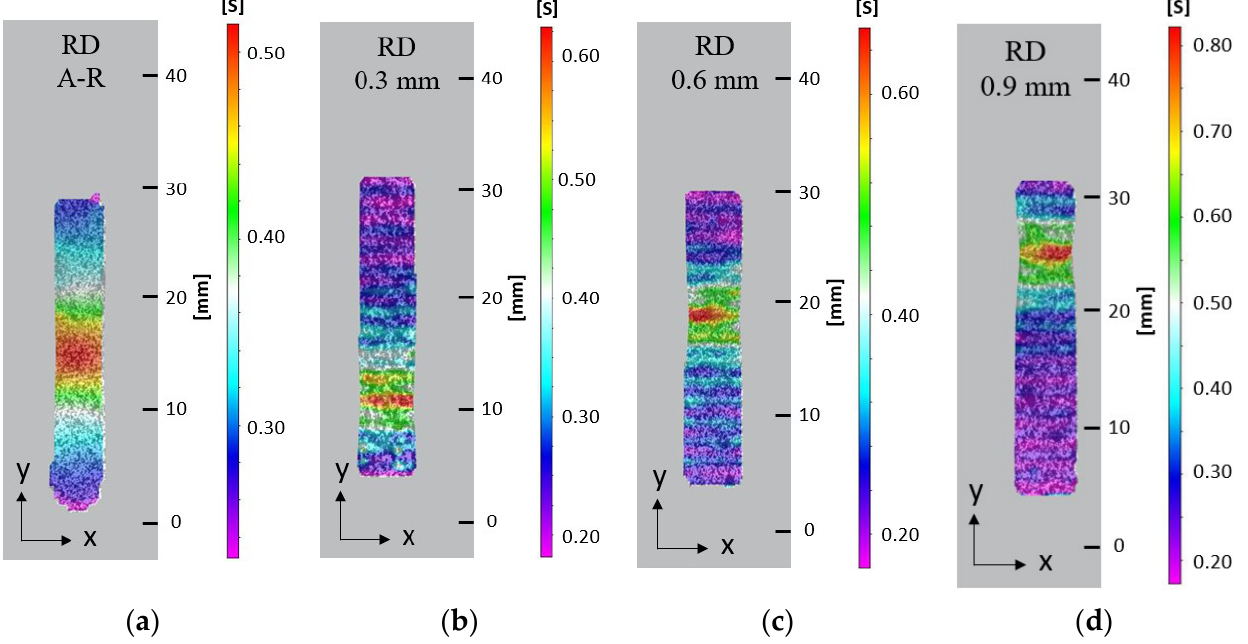
Figure 12. Effective surface strain at 90% extension on tensile samples orientated in substrate RD: